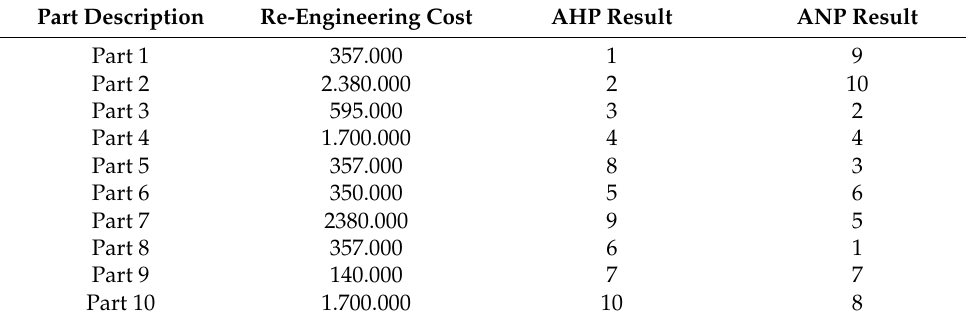
Table 12. Re-engineering cost and multi-criteria analysis results.